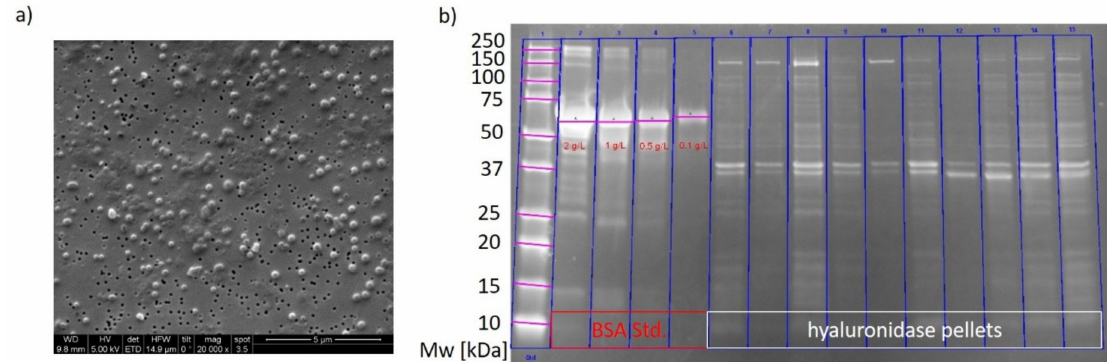
Figure 3. ( a ) SEM of hyaluronidase IBs. The bright spots are IB beads, while dark gray spots are host cell related impurities after the washing procedure; ( b ) SDS-PAGE of two hyaluronidase cultivations. Lane 1 is the molecular weight ladder, lane 2 to 5 the BSA standard, lane 6–10 and lane 11–15 two respective IB samples from two cultivations with sampling times of 4, 6, 8, 10 and 12 h of